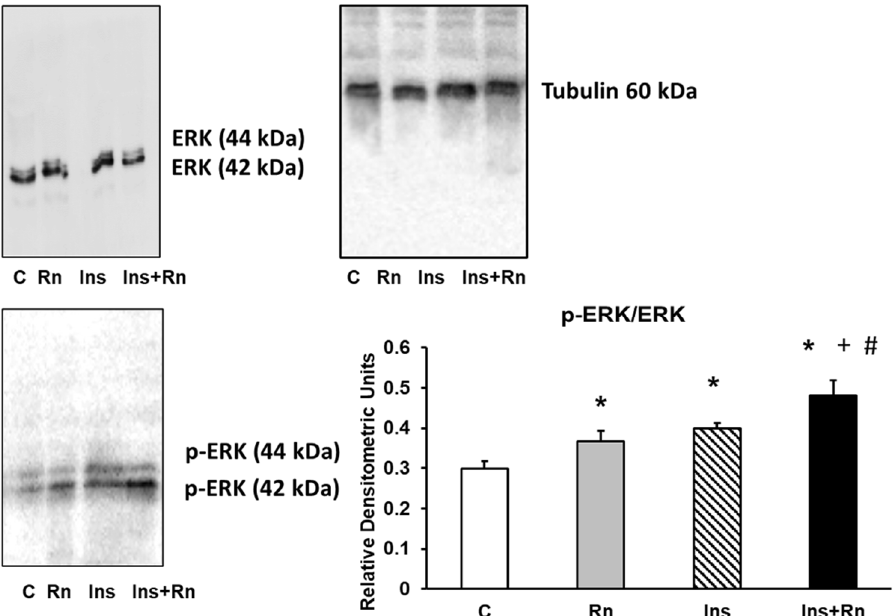
Figure 5. Effect of Ins and Rn on p-ERK and ERK protein expression. Astrocytes were incubated without Ins or Rn (control, C), with Rn (10 − 6 M), with Ins (10 − 8 M), or with Ins + Rn (10 − 8 M + 10 − 6 M) for 24 h and collected to determine p-ERK (1:500), ERK (1:500), and Tubulin (1:3000) protein expressions by Western blot. A representative immunoblot is shown in the panel. Data are mean ± SD of four independent experiments (four different rats). * p < 0.05 vs. control. + p < 0.05 vs. Rn. # p < 0.05 vs. Ins.